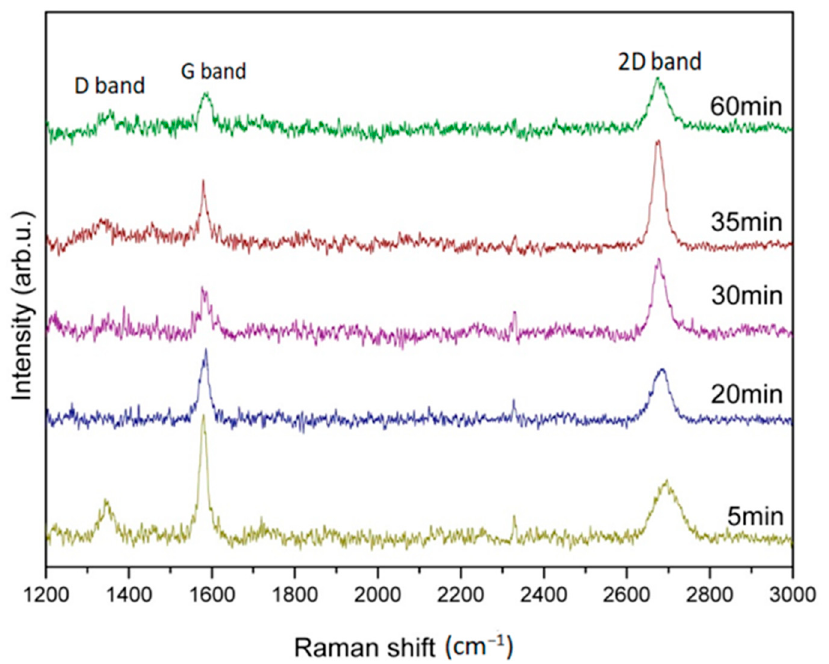
Figure 6. Raman spectra of graphene grown with optimal H 2 /Ar gas flow compositions of 15/20 sccm and temperature of 900 ◦ C in different time duration of 5, 20, 30, 35, and 60 min., respectively.